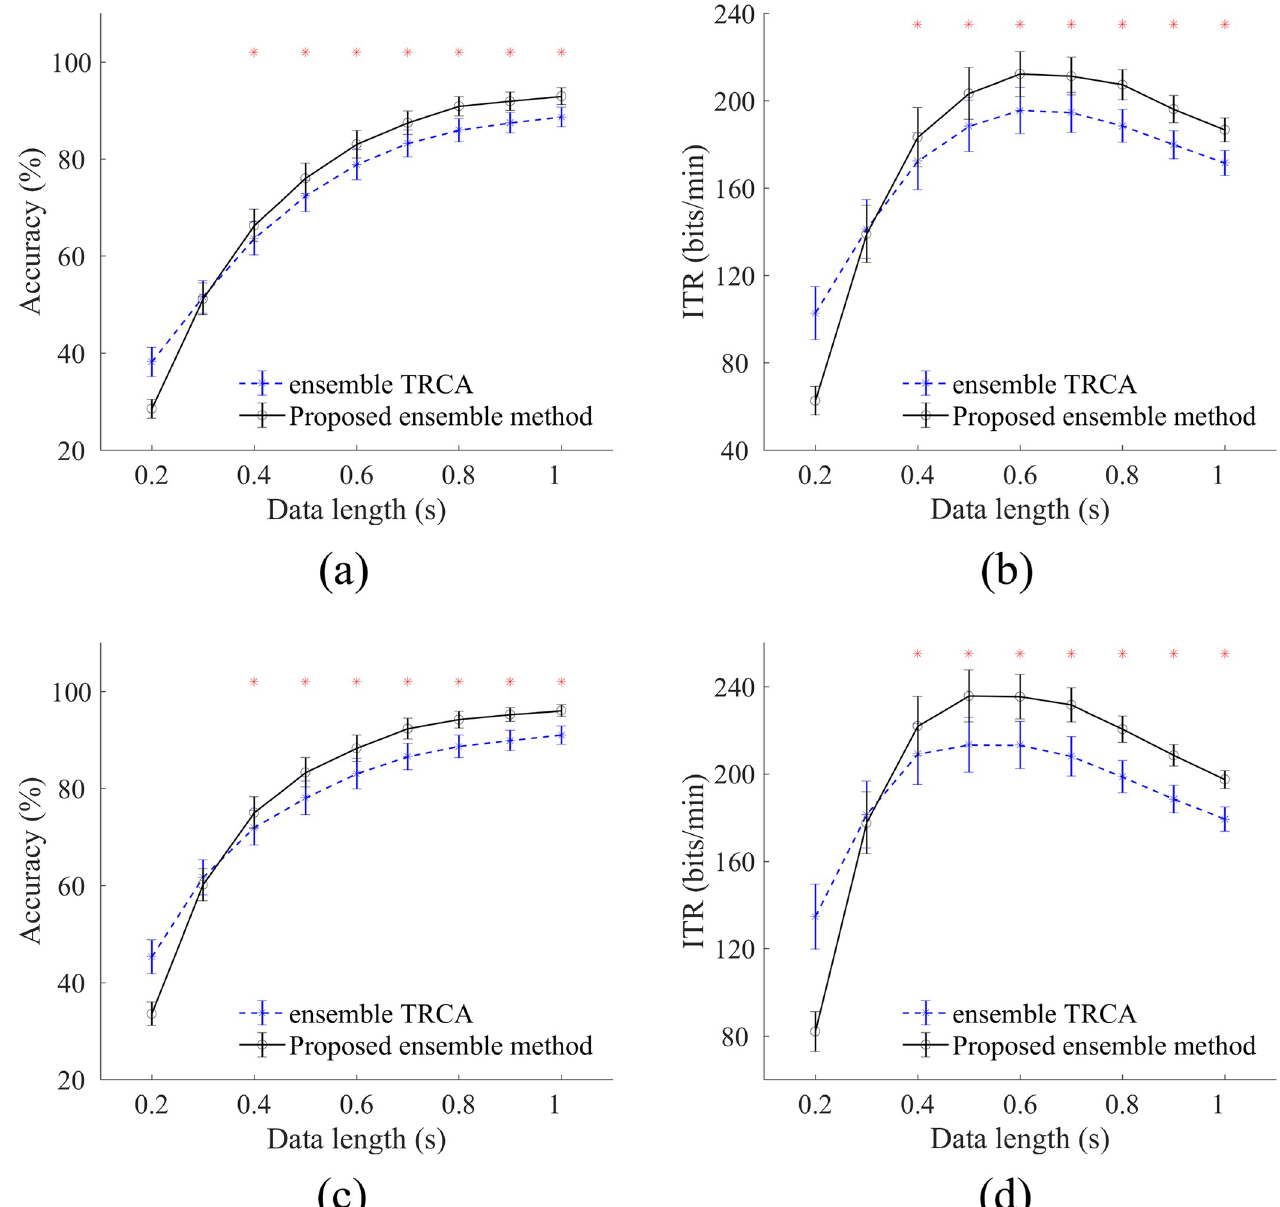
Fig 4. Average accuracies, (a) and (c), and ITRs, (b) and (d), across subjects for ensemble TRCA and ensemble version of the proposed method at different time windows. Results in the first and second rows are derived without and with the filter bank, respectively. Number of sub-bands is set to 4. Asterisks represent significant difference between the two methods by paired t-tests at time windows greater than 0.3 ( � p < 0.001). Error bars show standard